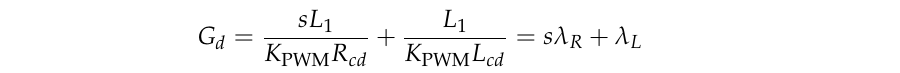
Figure 16. Bode diagram of multi-parallel HCGIs with difference